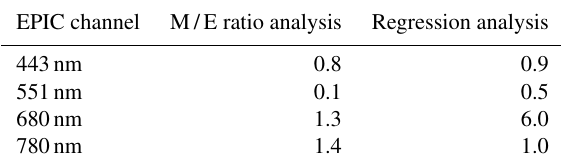
Table 3. The effect of spectral adjustment on calibration gain co- efficients for Version 2 data. The values in the table are calculated by subtracting the gain coefficients for data with spectral correc- tion from the corresponding coefficients for data without spectral correction and dividing the result by the